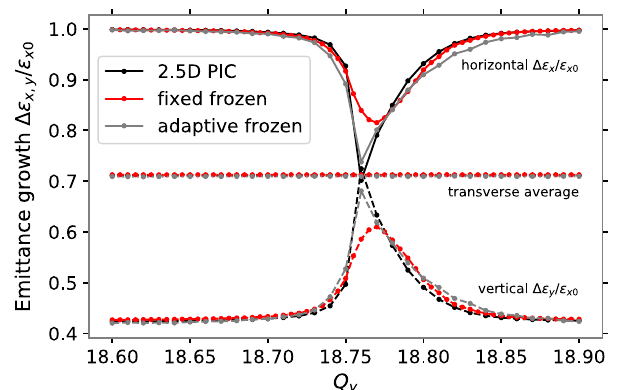
FIG. 2. Simulated emittance exchange across the Montague resonance for different space charge models. Solid lines (top part) indicate the horizontal plane, dashed lines (bottom part) the vertical plane, and constant dash-dotted lines (center) slightly above 0.7 the transverse